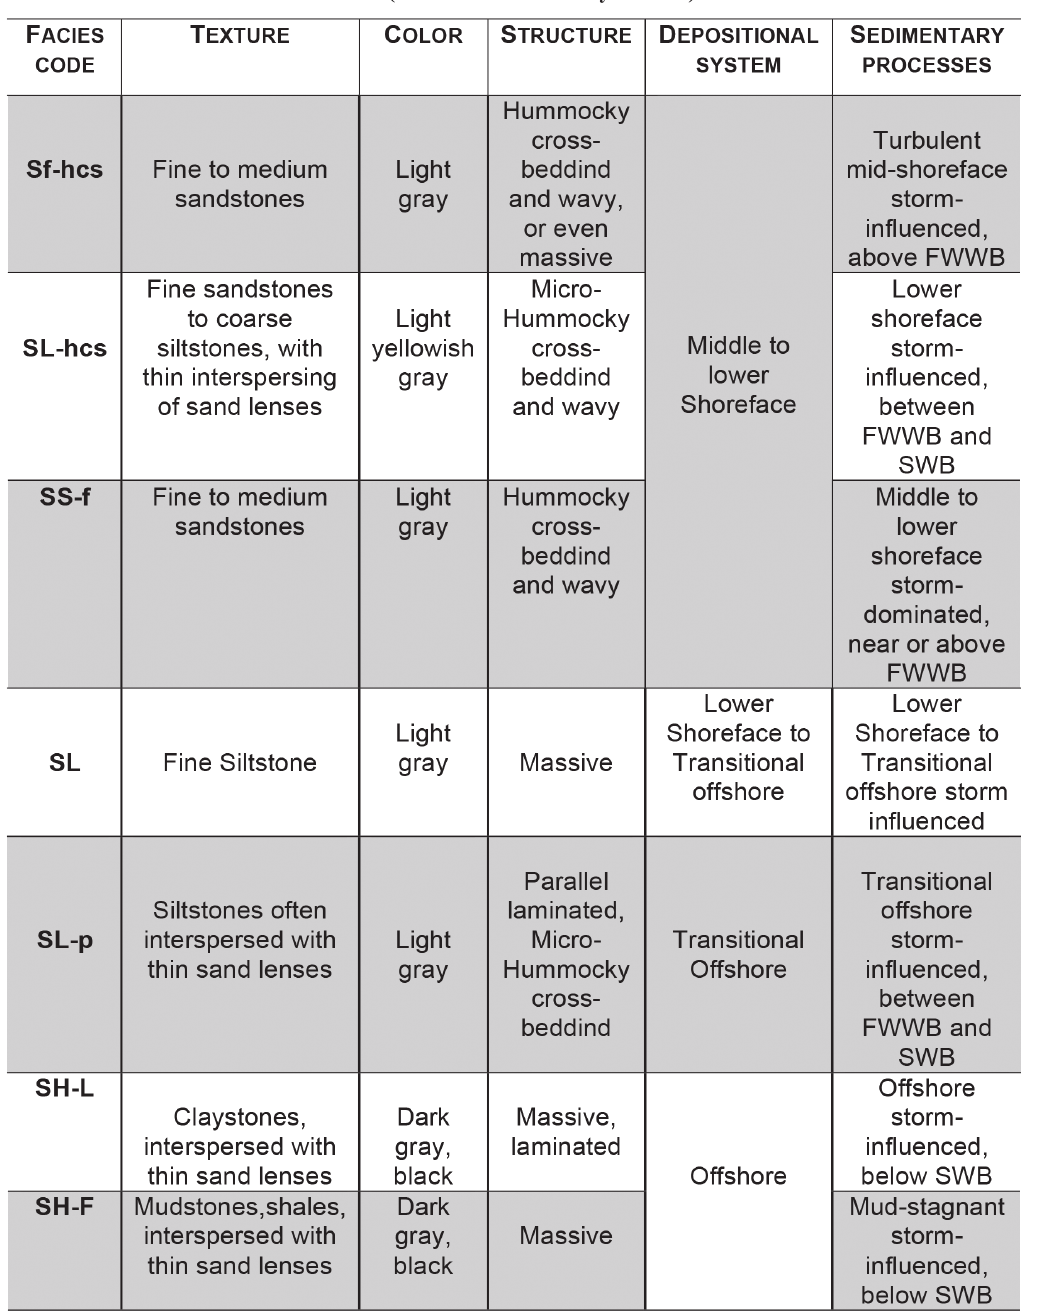
Lithofacies present at the fossiliferous site illustrated in Figure 1, representing three depositional systems characterized by seven sedimentary processes. the chondrichthyan fin remains were found in the SL-hcs facies. (modified from horodyski